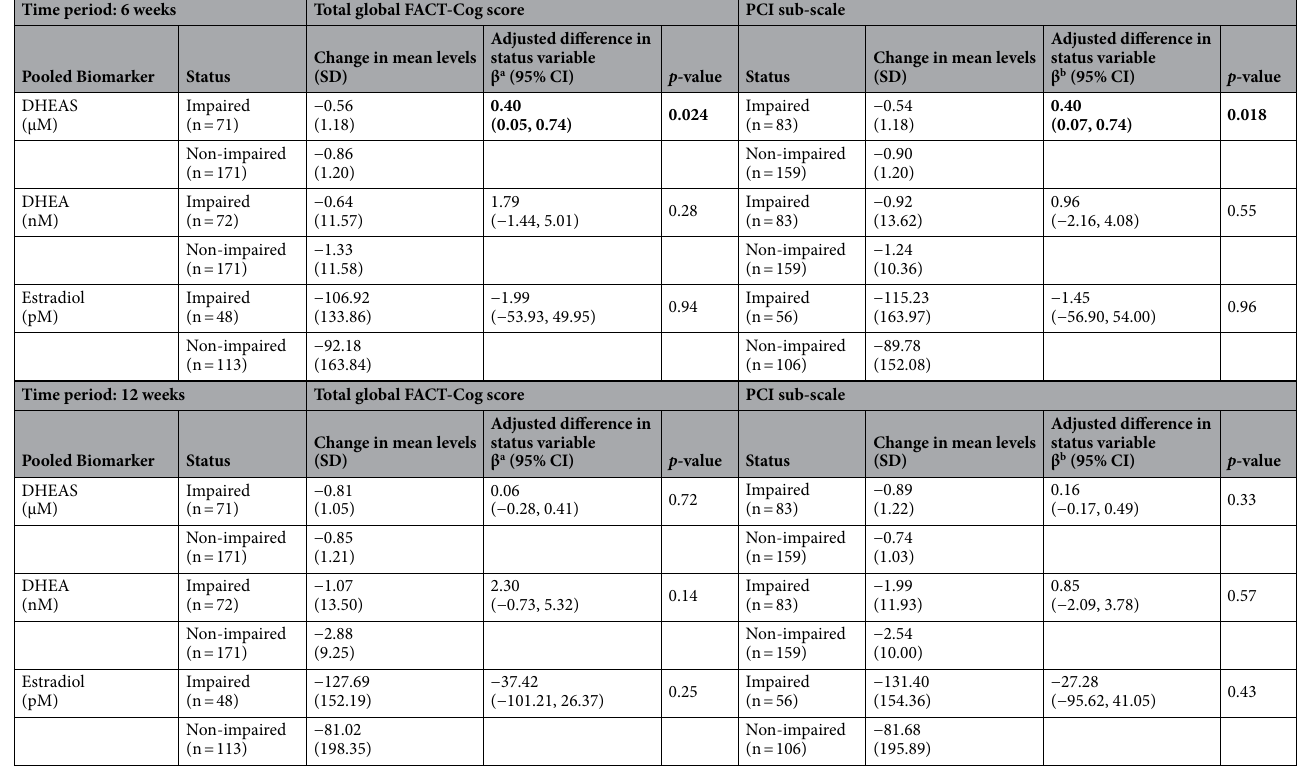
Table 4. Change in mean biomarker levels from baseline stratified by impairment status at 6 and 12 weeks from baseline. Βeta-coefficient represents the linear regression difference in mean biomarker levels between cognitive status for at least two time points (6 weeks relative to baseline and/or 12 weeks relative to baseline). Status is defined by reduction of more than 10.6 points in the total FACT-Cog scores a and by reduction